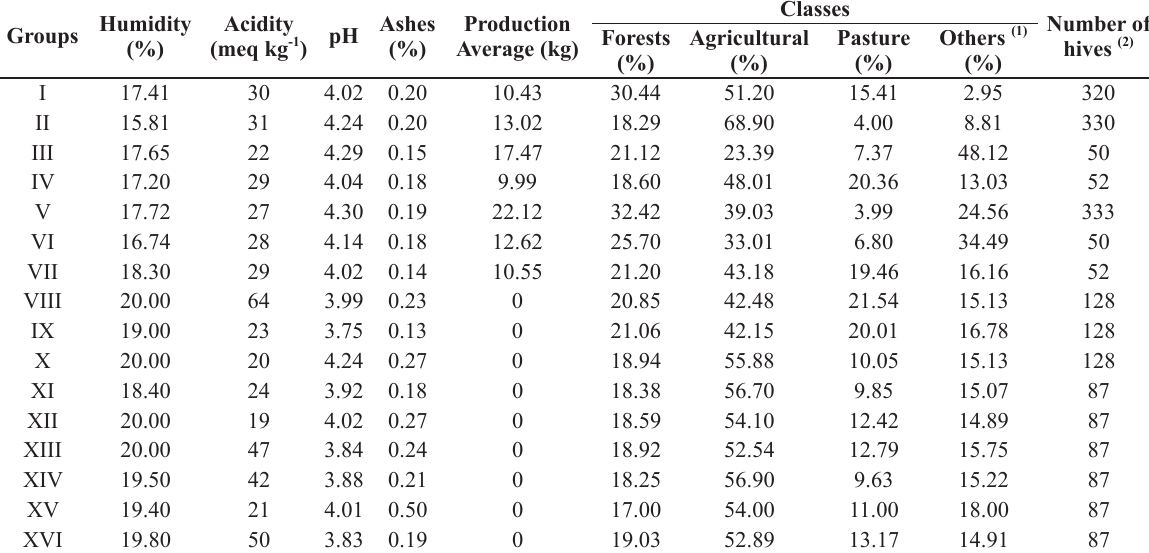
Average results of physicochemical analyzes of honey samples, the use and occupation of the ground around the hives within a radius of three Kilometers and the average data for production of the first